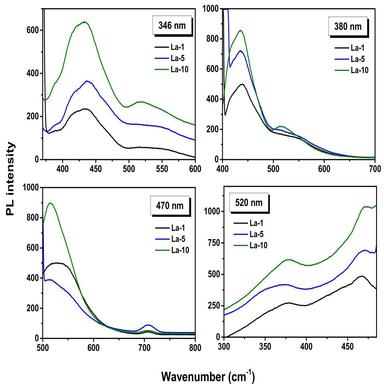
The obtained PL spectra of the prepared La-TUD-1 at different excitation wavelengths.